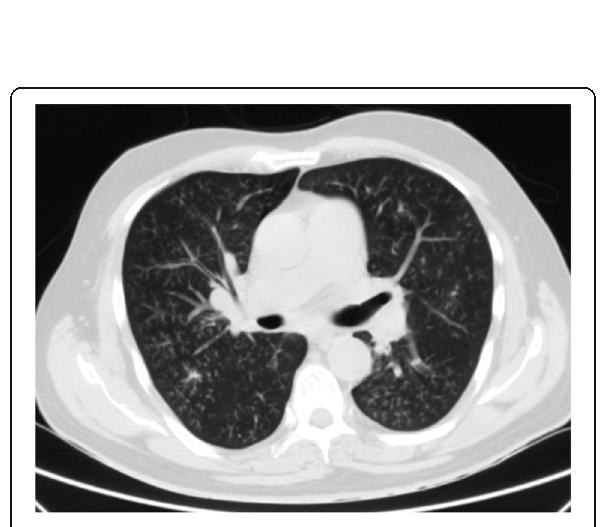
Fig. 20 Infectious bronchiolitis: thin section CT shows diffuse clustered branching tree-in-bud opacities